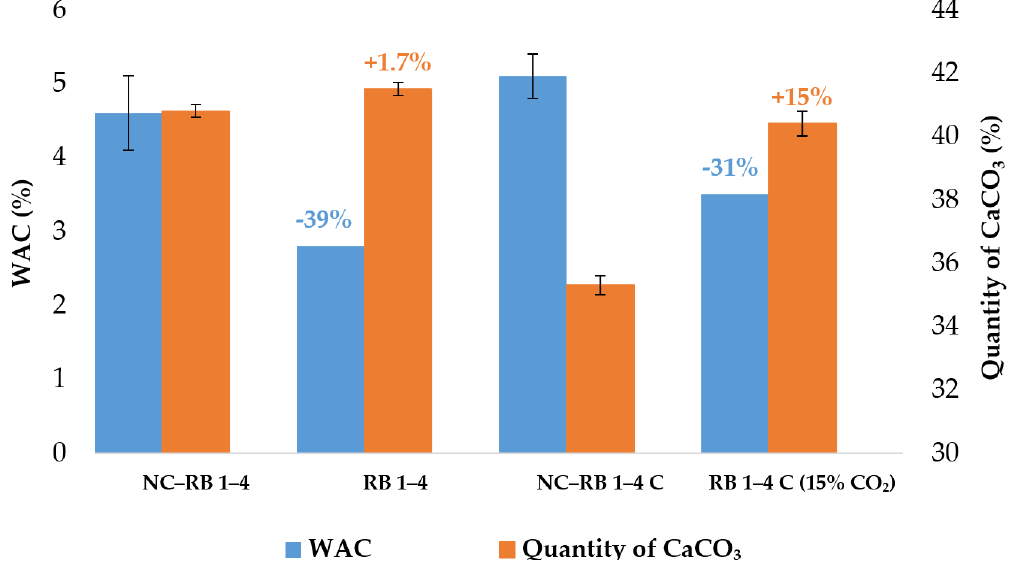
Figure 16. Correlation between the WAC and the formation of CaCO 3 (one WAC measurement for RCAs after